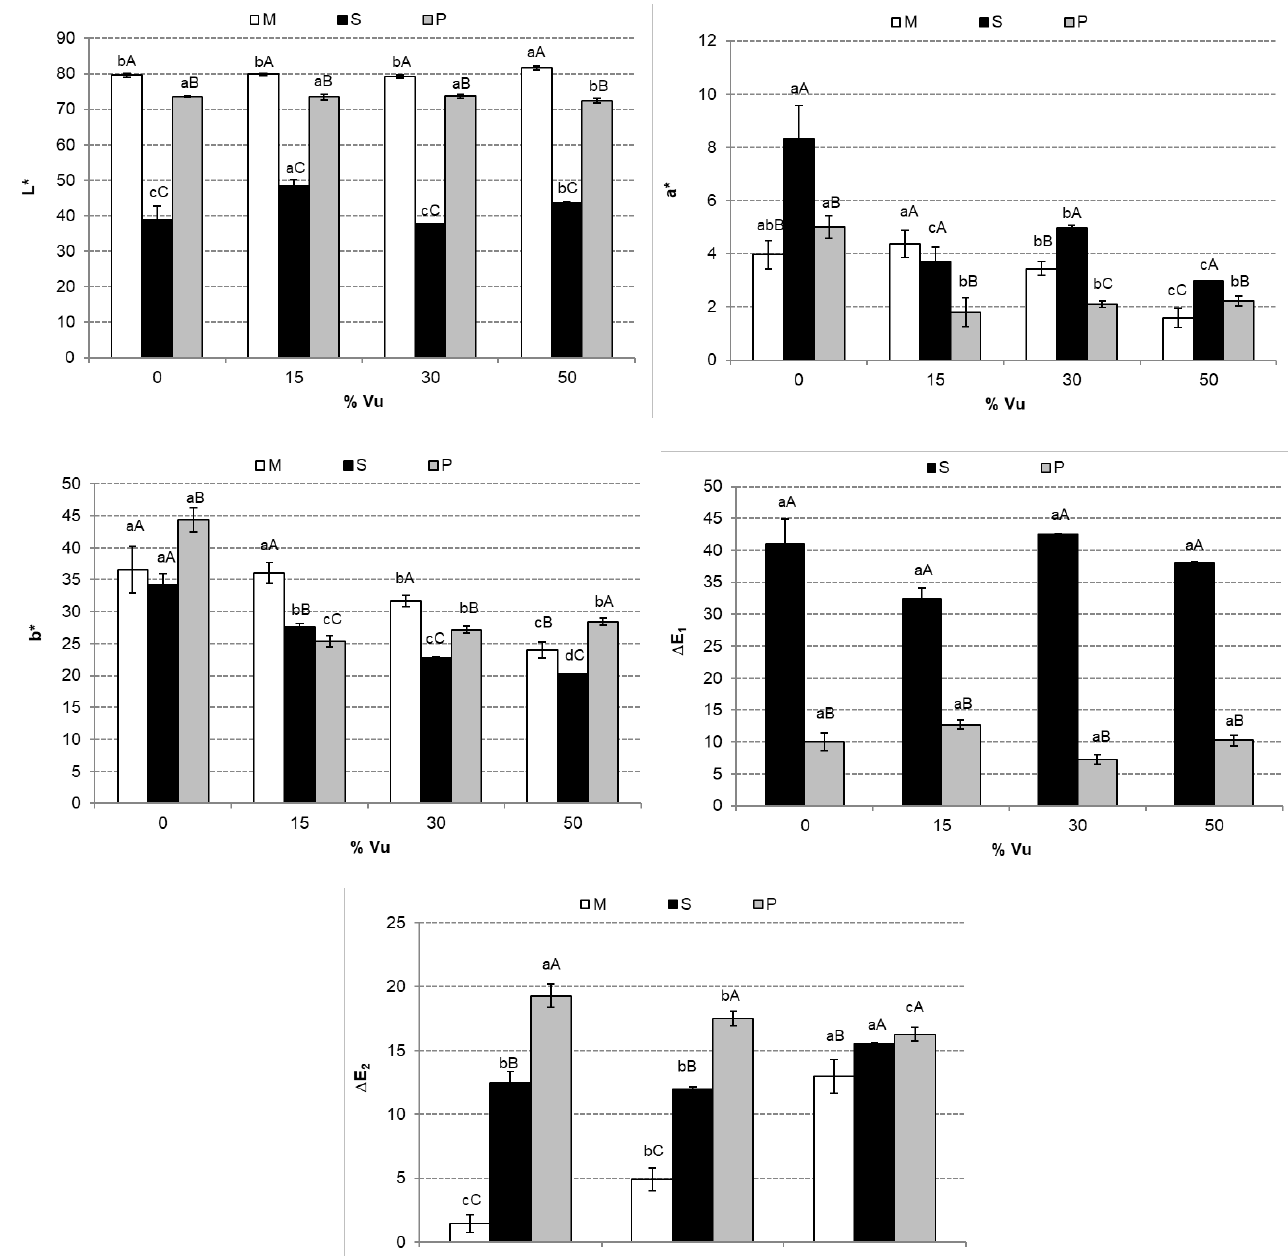
Figure 6. Mean values and standard deviation of color coordinates (L*, a*, and b*) and the total color differences ( Δ E 1 and Δ E 2 ) of the mixtures (M), the section of the pellet (S), and powder (P). For each parameter, the same small letter indicates homogeneous groups established by ANOVA ( p < 0.05) by comparing the Vu percentages (0, 15, 30, and 50) in M, S, or P. For each Vu percentage (0, 15, 30, and 50) and parameter, the same capital letter indicates homogeneous groups established by ANOVA ( p < 0.05) by comparing M, S, and P.